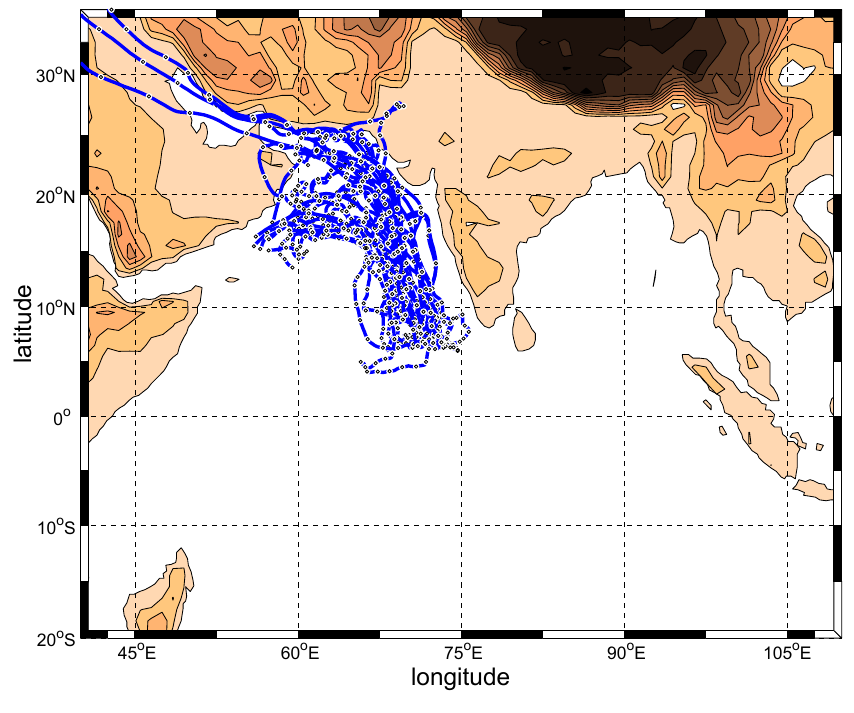
Fig. 3. 10 days backward trajectory cluster with the arriving hight of 50m for the data selection “Arabian